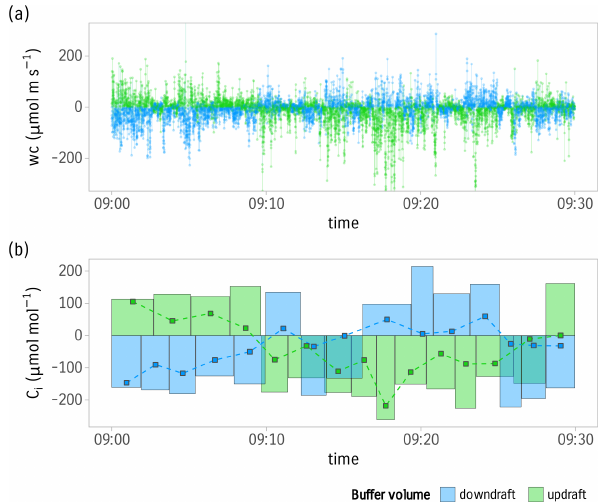
Figure 6. Sample accumulation using the STEA method. An exam- ple of 30min of measurements: (a) samples wc are collected based on wind direction and proportional to its magnitude. (b) Short in- tervals are accumulated. The variable short interval duration guar- antees equal accumulated volume for consecutive short intervals. Points are the concentrations C i measured by the gas analyzer. The area of each rectangle represents the accumulated sample volume in arbitrary units and is equal to the relative weight for each concen- tration measurement. The sum of all measurements C i weighted by the relative sample volume will equal the covariance. Data are from